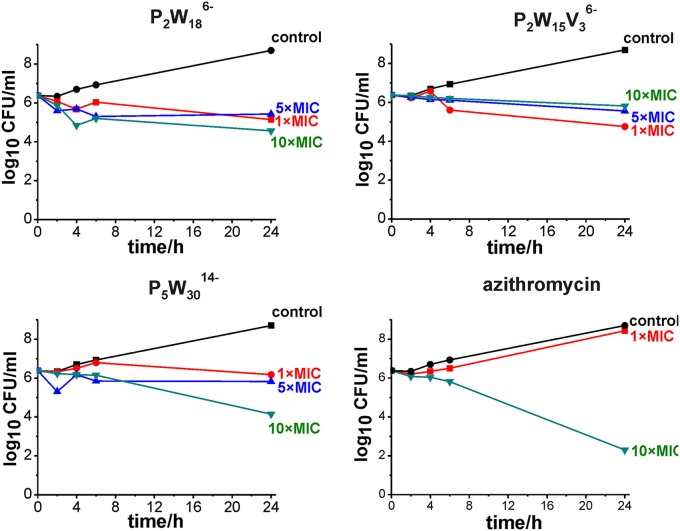
Time-kill curves for Dawson P2W186- and P2W15V36-, Preyssler P5W3014- POTs and azithromycin at minimum inhibitory concentration (MIC) (red), 5-fold (blue) and 10-fold MIC concentration (green) against M. catarrhalis ATCC23246 strain. Control represents uninhibited bacterial growth (black).